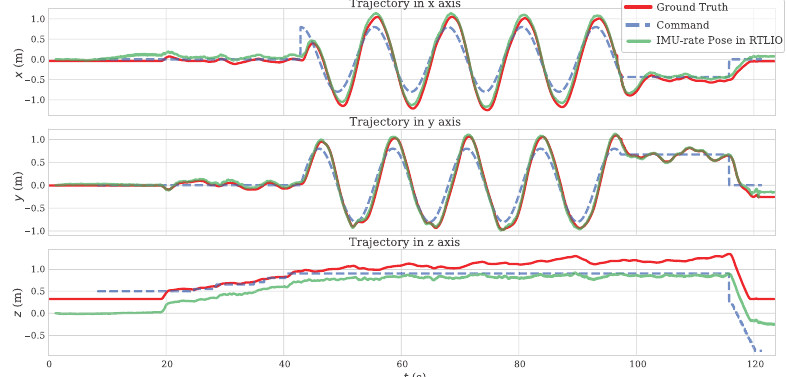
Figure 10. Flight trajectory with RTLIO along the x , y , and z axes.